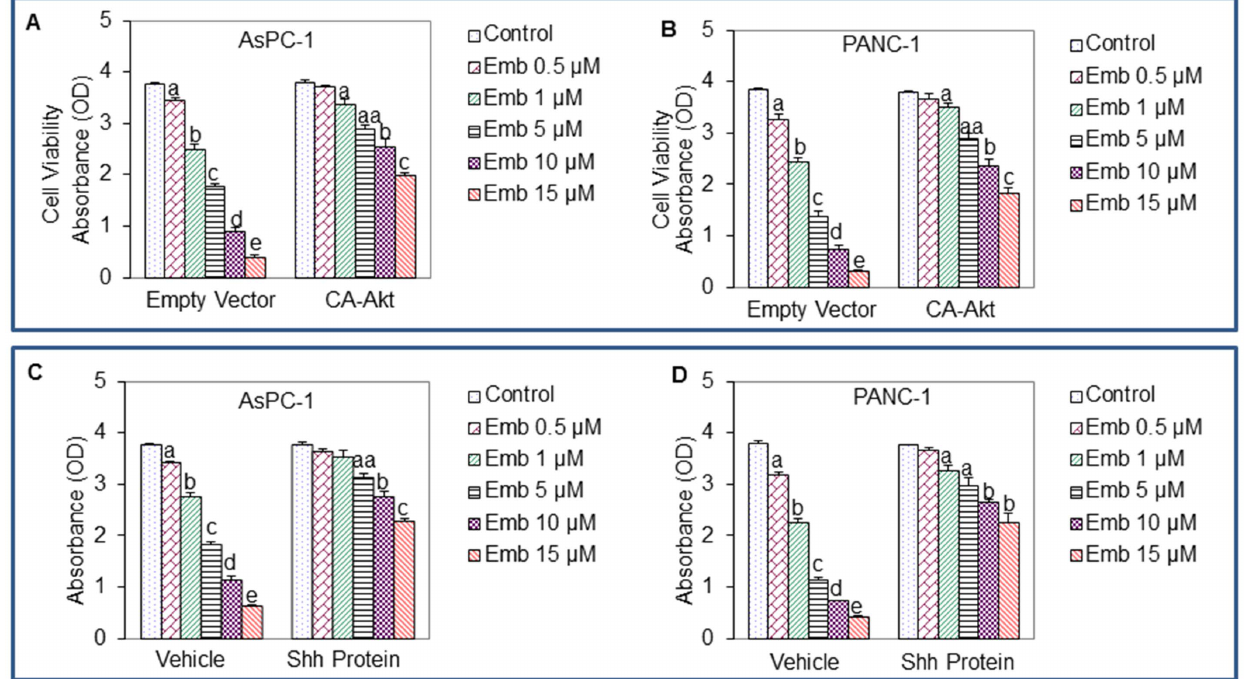
Figure 2. Constitutively active Akt or Shh protein inhibits the anti-proliferative effects of embelin. (A and B), Inhibition of anti- proliferative effects of embelin by constitutively active Akt. Pancreatic cancer AsPC-1 and PANC-1 cells were transiently transfected with either empty vector or constitutively active Akt (CA-Akt), and treated with various doses of embelin (0–15 m M) for 48 h. Cell viability was measured by XTT assay. (C and D), Inhibition of anti-proliferative effects of embelin by Shh protein. Pancreatic cancer AsPC-1 and PANC-1 cells were pretreated with Shh protein (2 m M) for 2 h, and treated with various doses of embelin (0–15 m M) for 48 h. Cell viability was measured by XTT assay. Data represent the mean 6 S.D. a, aa, b, c, d, and e=significantly different from each other, P ,